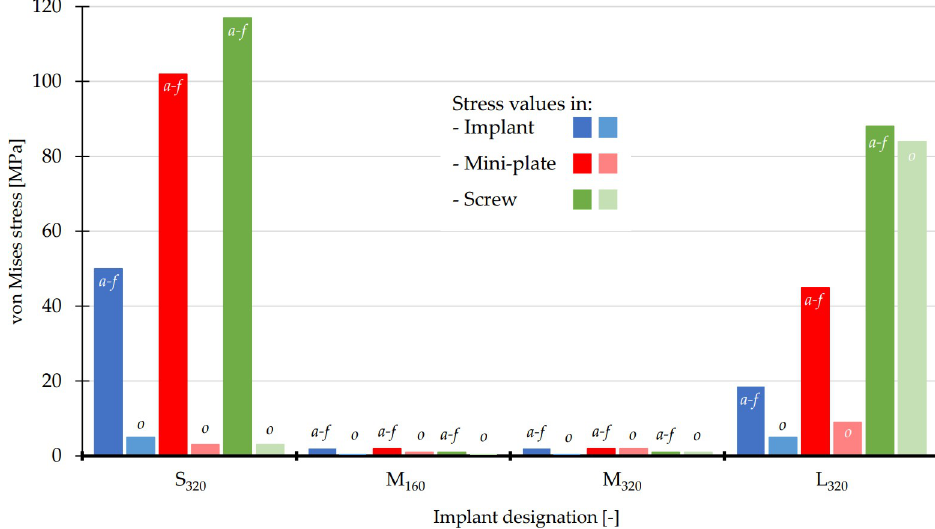
Fig 8. The maximum values of von Mises stresses in implant (blue colors), fixation mini-plates (red colors) and screws with micro-thread (green colors). The values of as-fixed state were labeled with ,, a-f ” and the values of 30% osseointegration levels (30% of bonded contact at BIC) with ,,o”.